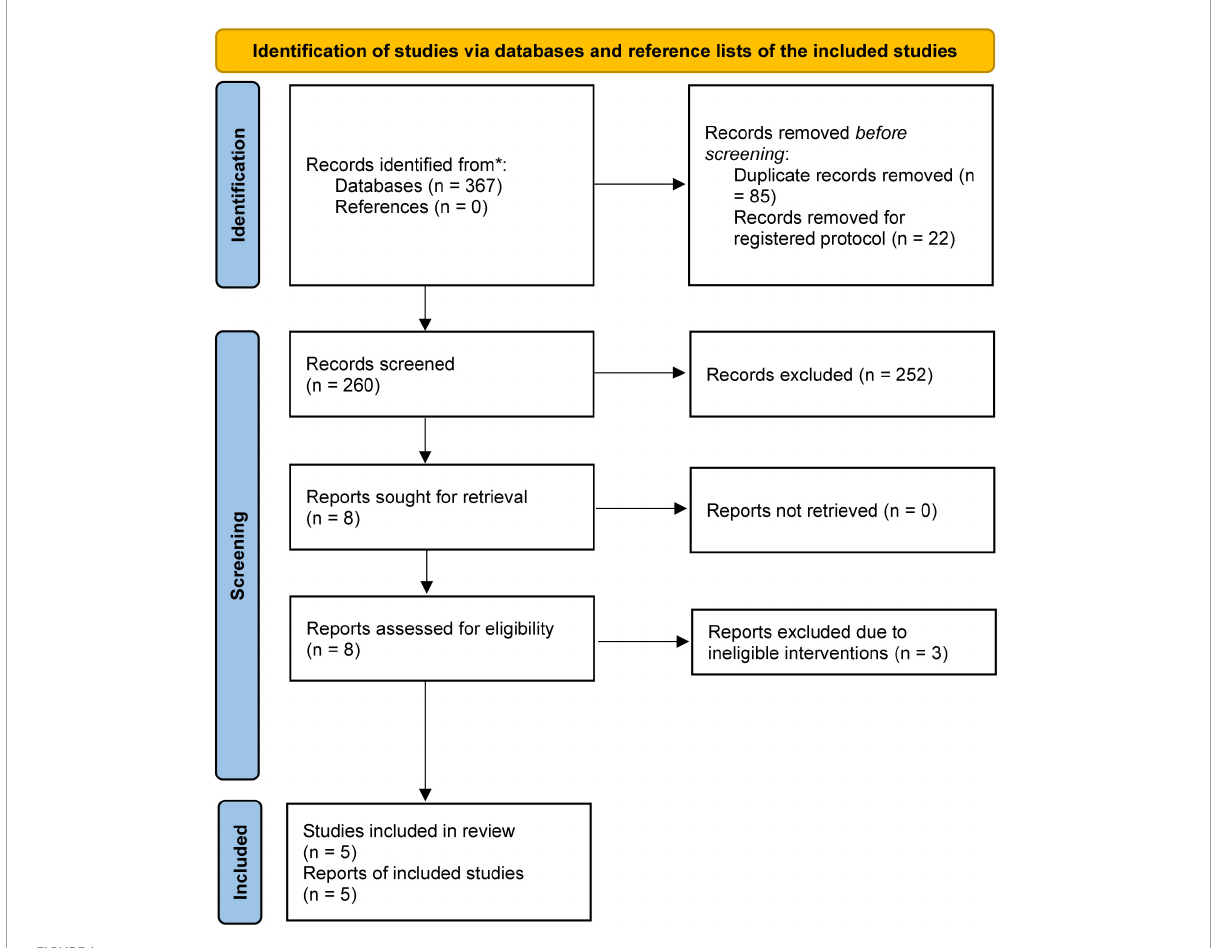
FIGURE1 PRISMA flow diagram of study